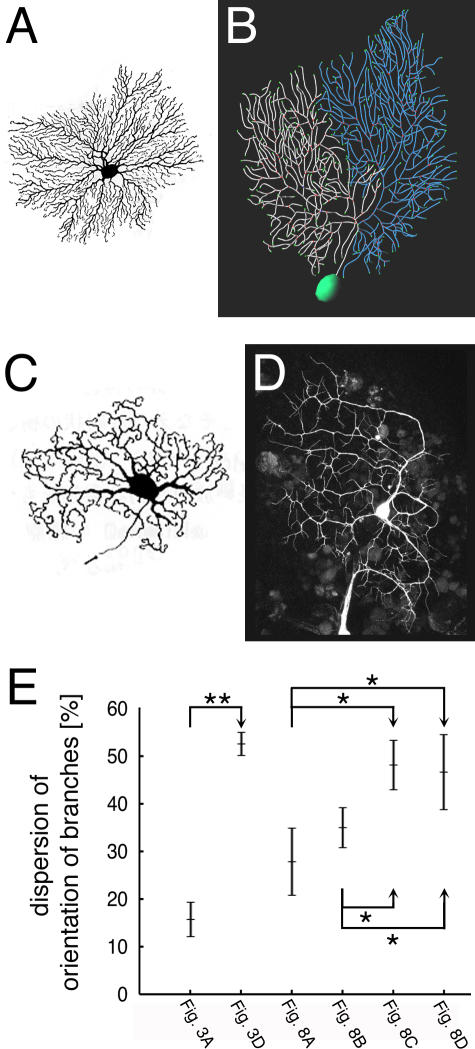
Two Distinctive Branching Patterns of Real Neurons(A,B) Smooth and well-aligned type. A neuron in thalamic nuclei in monkey (A) and Purkinje cell at postnatal day 25 (B).(C,D) Rugged and less-aligned type. A neuron of inferior olivary complex of monkey (C) and a remodeled class I da neuron at a pupal stage, which was visualized with ppk-GAL4 UAS-mCD8::GFP [49] (D). Images in (A and C) were taken from [50].(E) Quantification of DOB in the generated patterns in our computer simulation. Data are presented as the means ± SD. A single asterisk indicates p < 0.01 (t-test), and double asterisks indicate p < 0.001 (t-test).